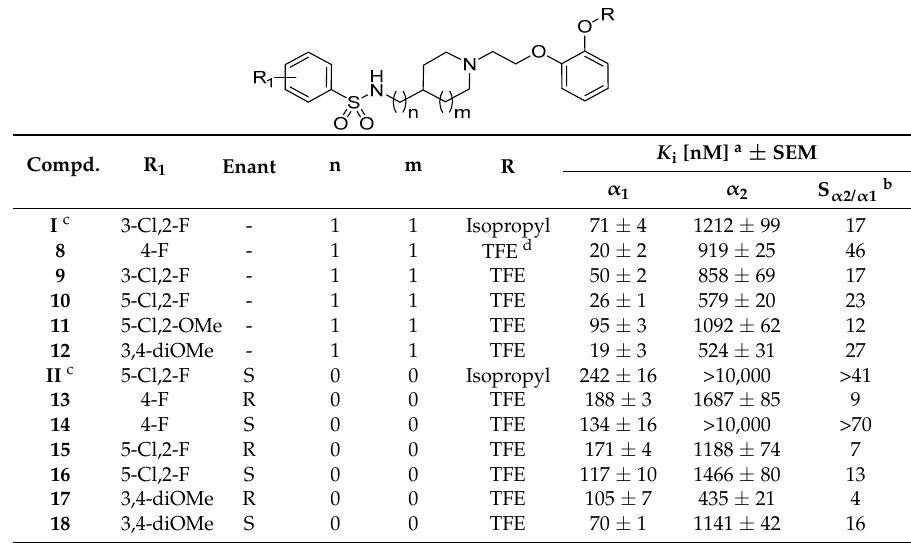
Table 1. The biological data of compounds 8 – 18 for adrenergic α 1 - and α 2 -receptors.